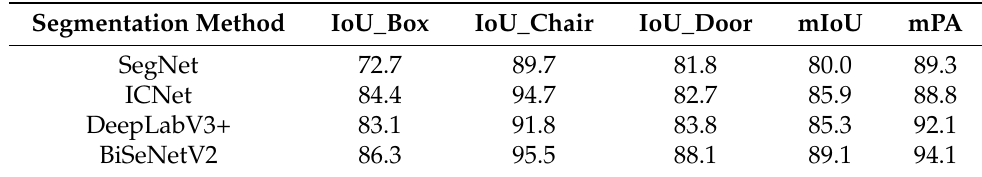
Table 3. Semantic segmentation results (%) for each class on self-built dataset.